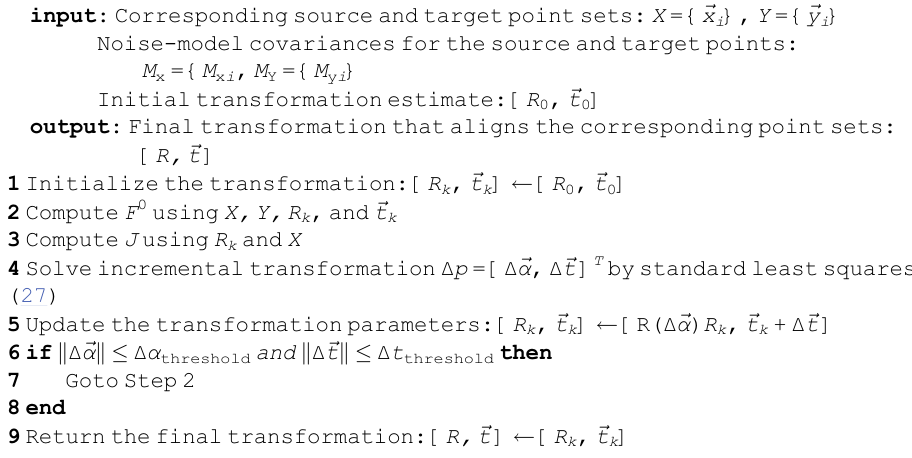
Algorithm 5. GTLS Registration of Corresponding Point